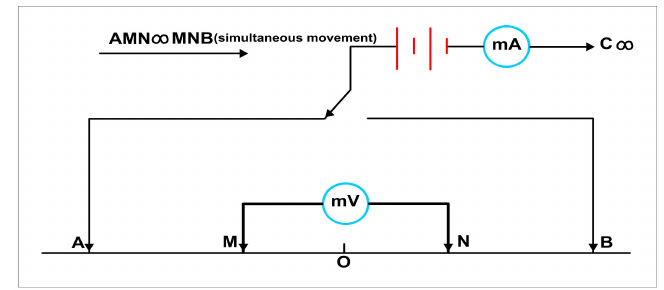
Figure 5. Joint cross-sectional view of the device.